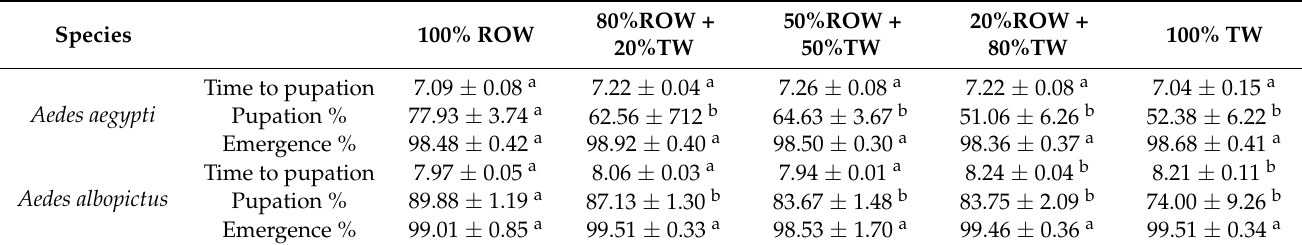
Table 3. Mean time to pupation, pupation and emergence percentages (mean ± se) in Aedes aegypti and Aedes albopictus reared under different water hardness treatments. ROW = reverse osmosis water, TW = tap water. Within a row, different letters with the control treatment (100% ROW) indicate a statistically significant difference ( p < 0.05).